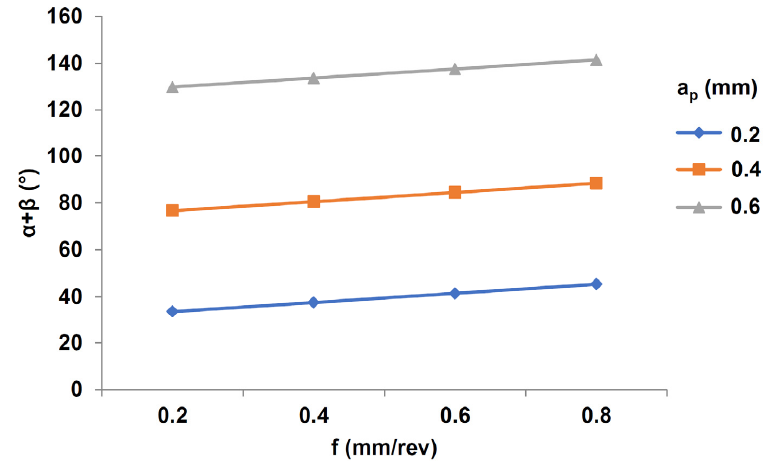
Figure 17. Effect of feed on the α + β angle for r ε = 1.5 mm.